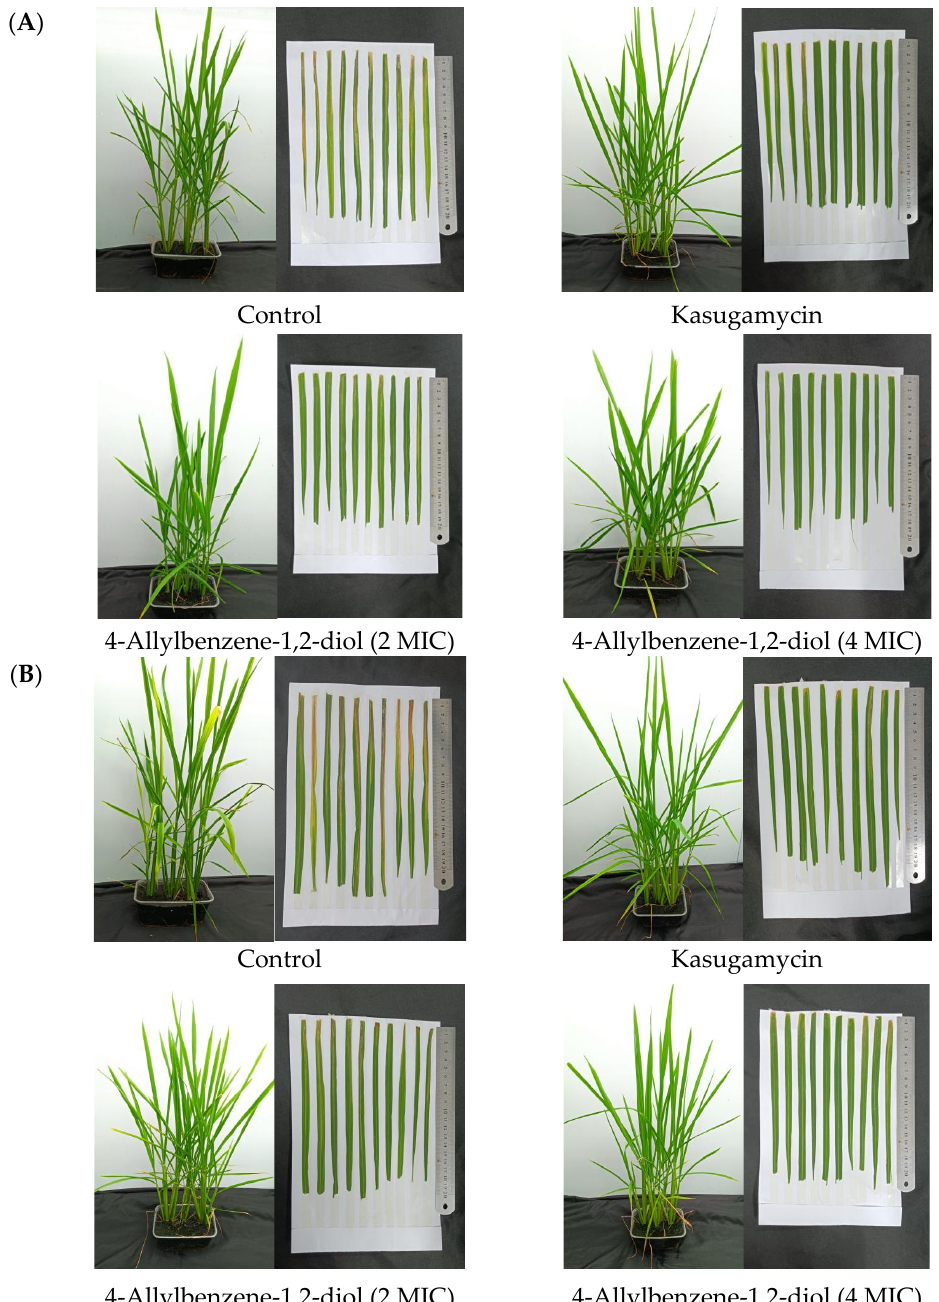
Figure 4. In vivo activities of 4-allylbenzene-1,2-diol against rice bacterial leaf blight ( A ) Protective activity; ( B ) Curative activity.